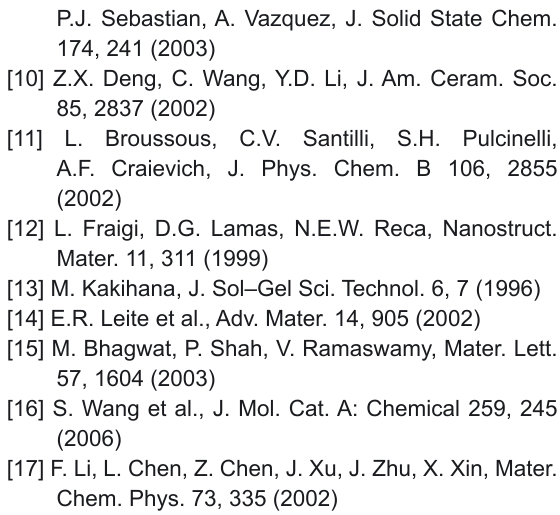
Table 4. Results of XRD, TEM and BET of Alumina doped SnO